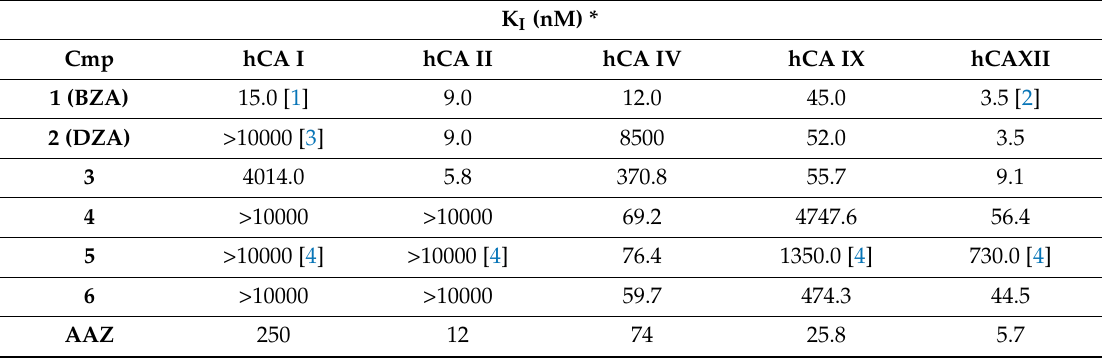
Table 1. Inhibition data of human CA isoforms I, II, IV, IX and XII with compounds 1 – 6 and AAZ by a stopped flow CO 2 hydrase assay